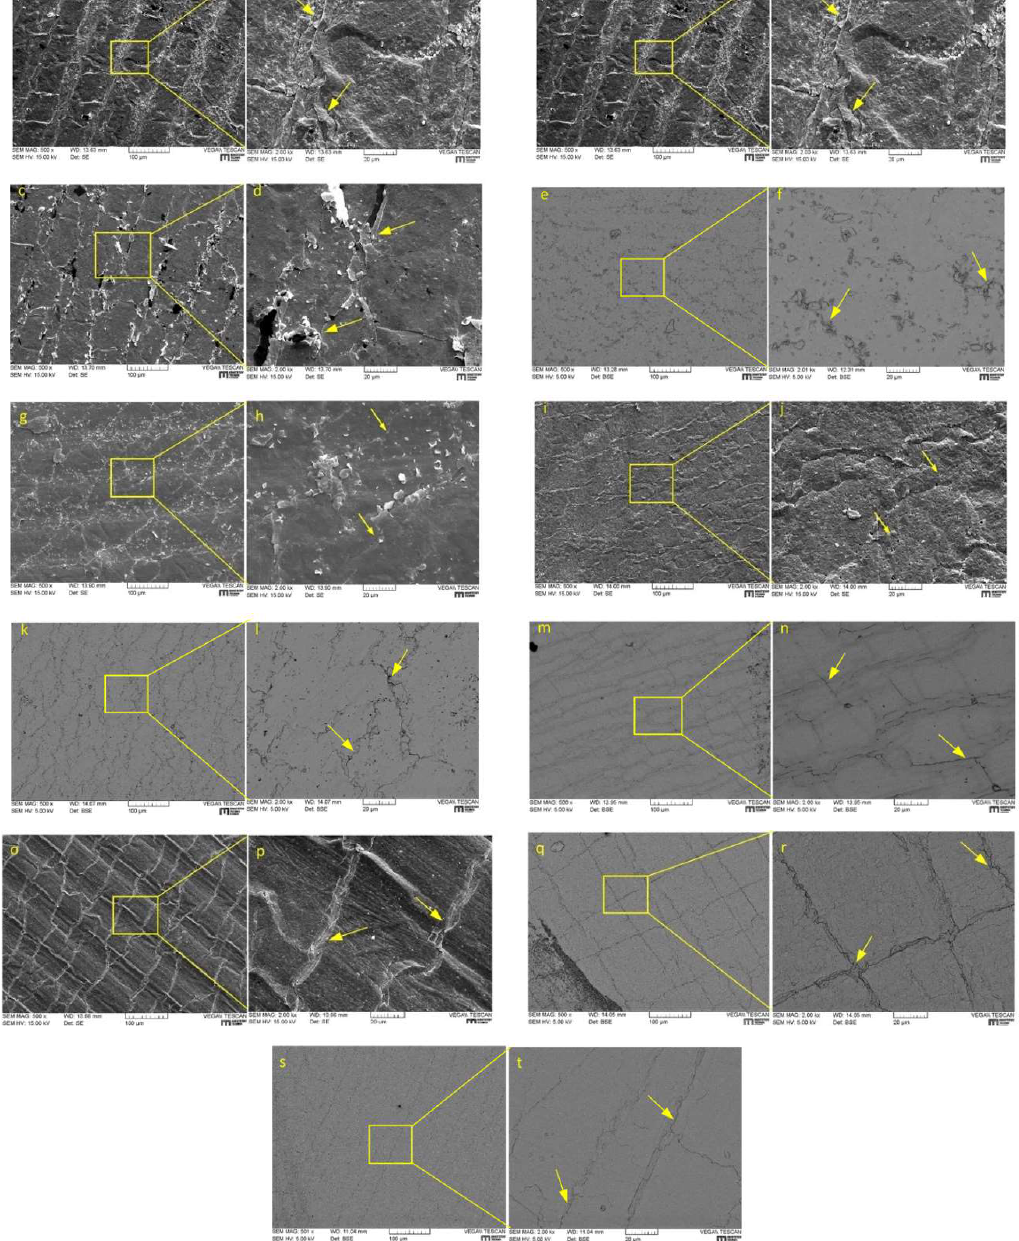
Figure 3. With 300 nm ( a,c ) and 150 nm DLC ( e ) coated hydrogenated nitrile butadiene rubber (HNBR); with 300 nm Hybrid_A coated HNBR ( g ), fluoroelastomer (FKM), ( i ) and nitrile butadiene rubber (NBR) ( o ); with 300 nm MoS 2 coated FKM ( k ), NBR ( m ) and thermoplastic polyurethane (TPU) ( s ); with 300 nm DLC coated TPU ( q ). High magnification ( b , d , f , h , j , n , p , r , s , t ) are shown to the right side of the respective low magnification (500×).